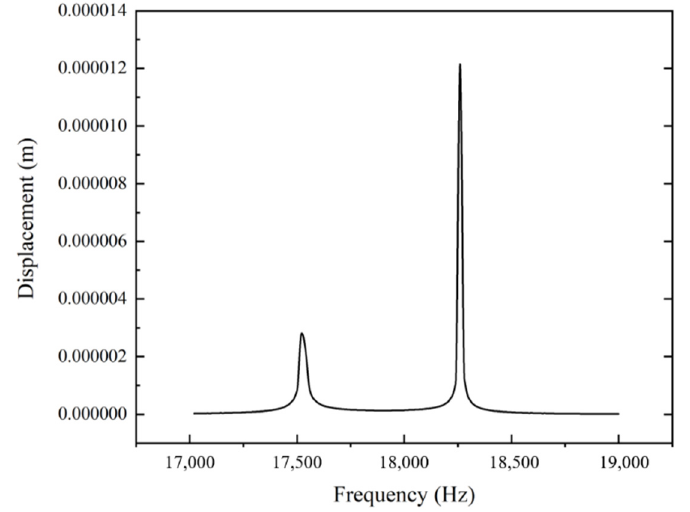
Figure 5. Displacement curve of the tool between 17,000 Hz and 19,000 Hz.